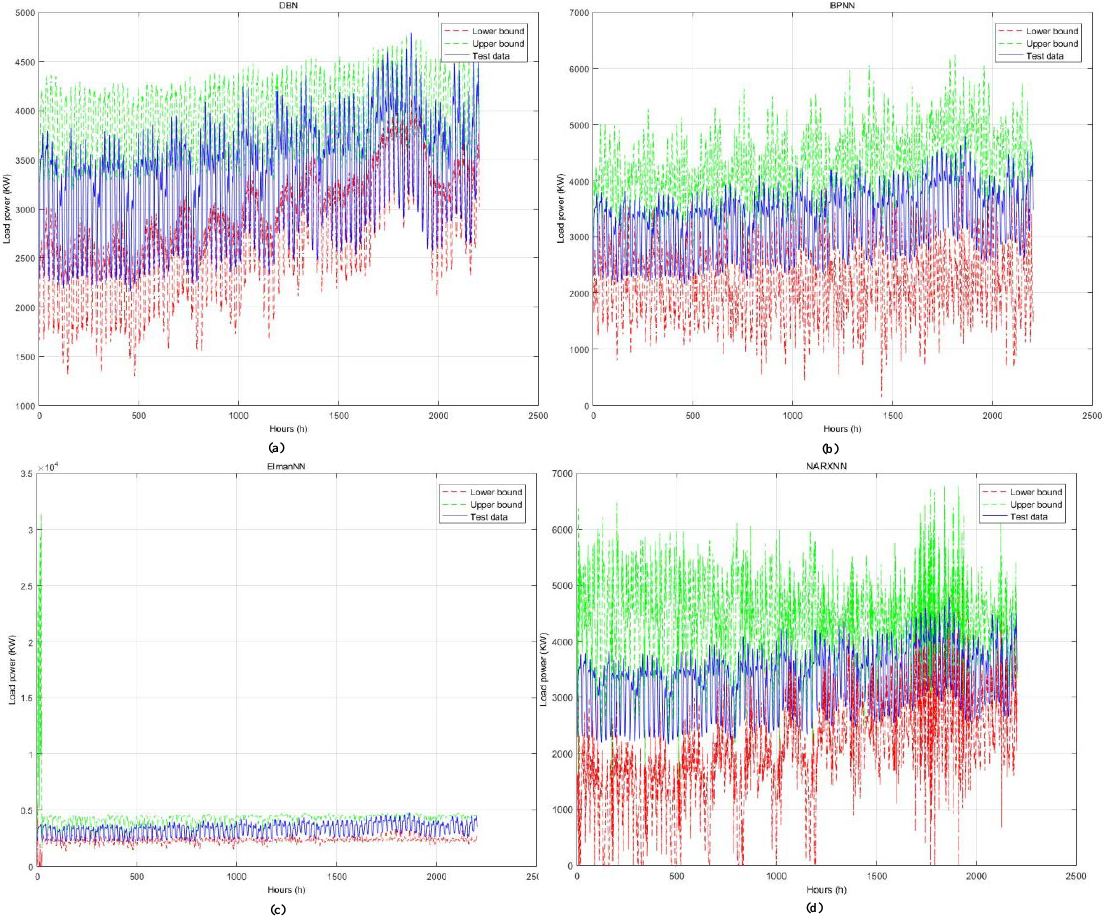
Figure 9. The prediction results by four models for the entire test data: ( a ) DBN-based PI; ( b ) BP network neural-based PI; ( c ) Elman network neural-based PI; ( d ) NARX network neural-based